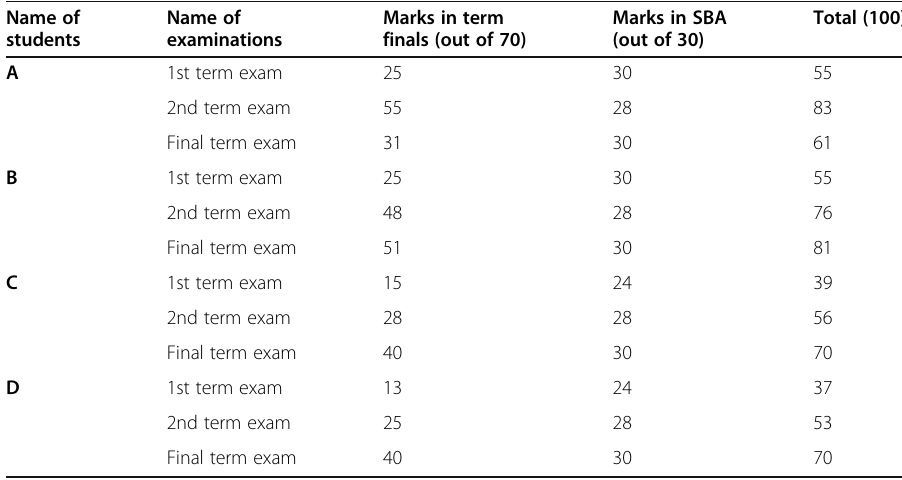
Table 5 Abundance of marks given in SBA (source: field notes) Name of Name of students examinations